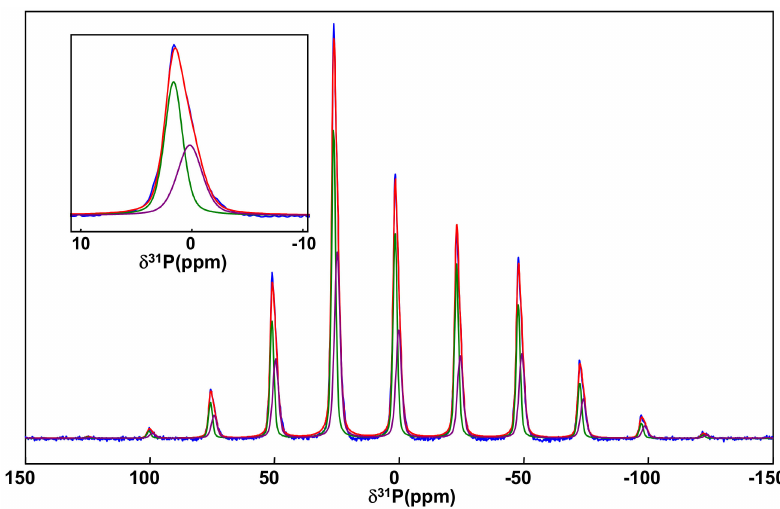
Figure 6. 31 P MAS NMR spectrum of LDH-BL (blue) and the corresponding fitting (red) using two sites (site 1: green and site 2: purple). Inset corresponds to the isotropic resonances.